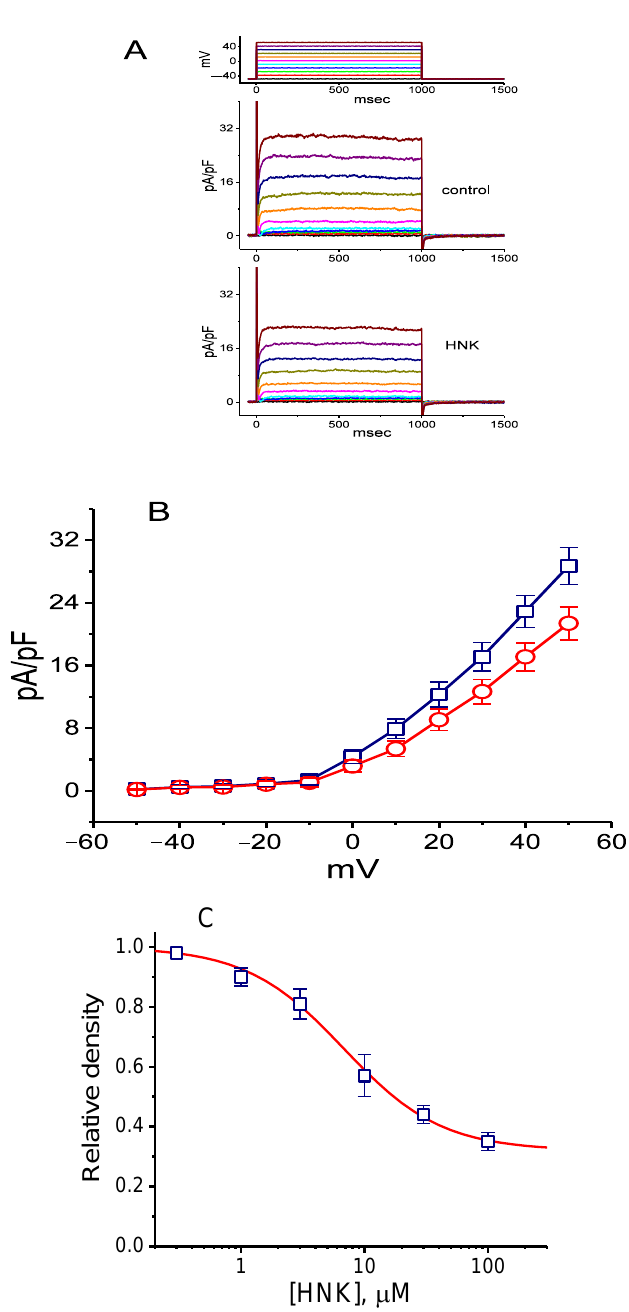
Figure 5. Inhibitory effect of HNK on the density of delayed-rectifier K + current ( I K(DR) ) in GH 3 cells. In these experiments, cells, bathed in Ca 2+ -free Tyrode’s solution containing tetrodotoxin (1 μM) and CdCl 2 (0.5 mM), were clamped at −50 mV and the voltage pulses from −50 to +50 mV in 10-mV steps were applied. Representative I K(DR) densities shown in the upper part of ( A ) are controls, and those in the lower part were recorded 2 min after the application of 10 μM HNK. The uppermost part is the voltage protocol used. ( B ) Mean current density versus voltage relationships of I K(DR) density obtained in the absence ( □ ) and presence of 10 μM HNK ( ○ ) (mean ± SEM; n = 8 for each data point). Current density was measured at the end of each depolarizing pulse. ( C ) Concentration–response relationship for HNK-induced inhibition of I K(DR) density (mean ± SEM; n = 7 for each data point). Current densities at the end of the pulse were generated as the examined cells were depolarized from −50 to +50 mV with a duration of 1 s. The smooth line represents best fit to the modified Hill equation. The value for IC 50 was estimated to be 6.8 μM.